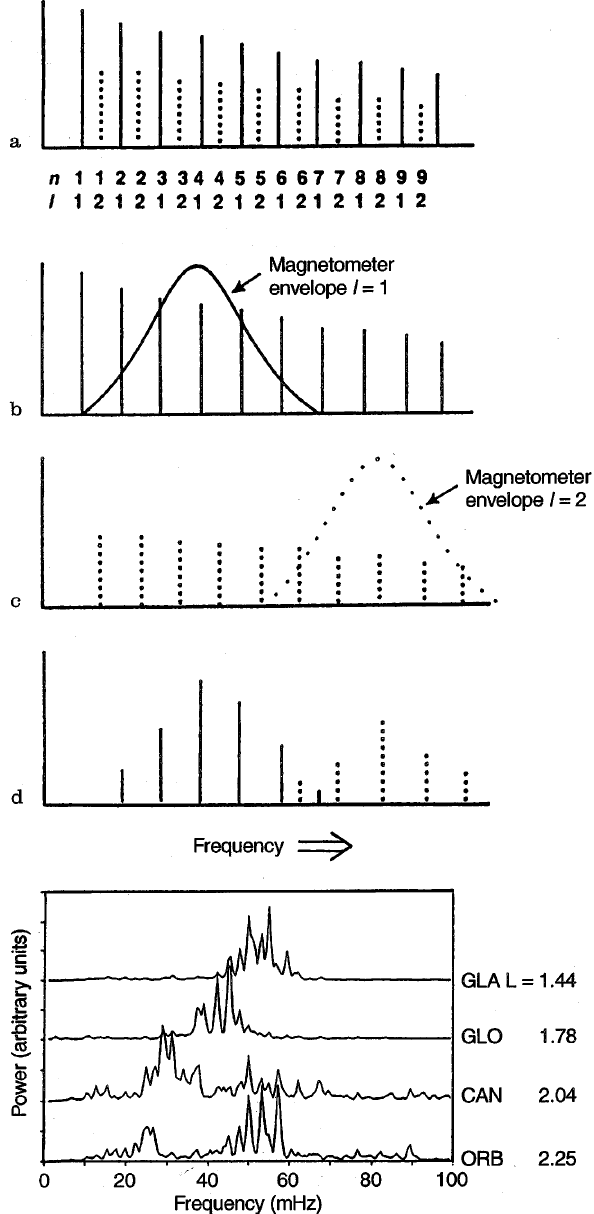
Fig. 5a–d. Model ( top ) and supporting low-latitude observations ( bottom ) of multiharmonic wave guide modes excited in the magnetosphere (adapted from Fig. 2 and 3 of Samson et al . 1995). In the model, wave guide modes are excited at frequencies (cid:120) by Eq. (3) as illustrated in a . A magnetometer on the ground observes a spectrum that consists of multiple envelopes centered at the frequencies of the local standing Alfve´ n waves, as shown in b , c , and